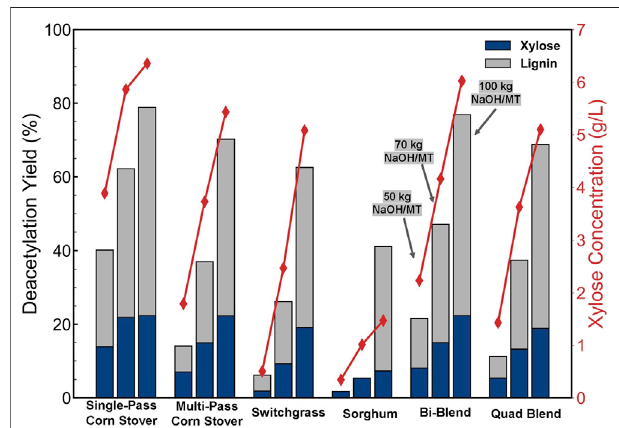
FIGURE 5 | DDA pretreatment xylose yields (Red bars are stacked on top of blue bars. Total xylose yields are represented by the top of red bars). The left bar in each cluster is data from the 150 ° C, 20 min, 1% H 2 SO 4 condition and the right bar represents the 170 ° C, 5 min, 1% H 2 SO 4 pretreatment condition. The numbers on the x -axis note the deacetylation alkali loading in kg NaOH/ODMT biomass with 50, 70, and 100 referring to low, medium, and high deacetylation severities,